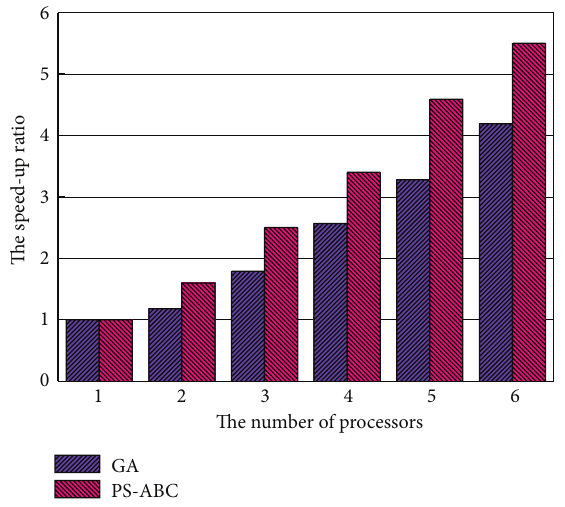
Figure 6: Comparison of GA and PS-ABC in speed-up ratio.